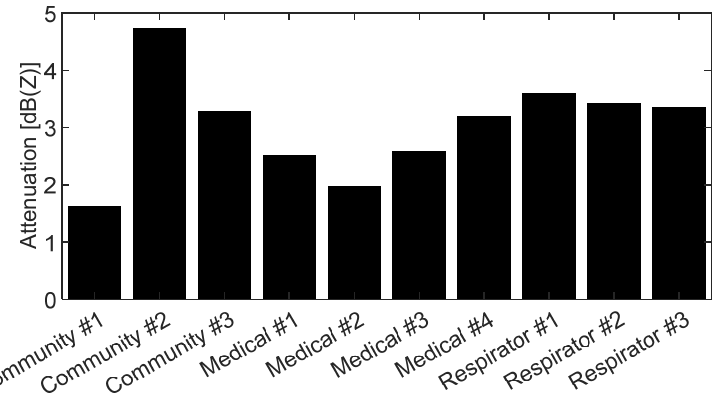
Figure 13. Acoustic attenuation of the 10 masks tested.